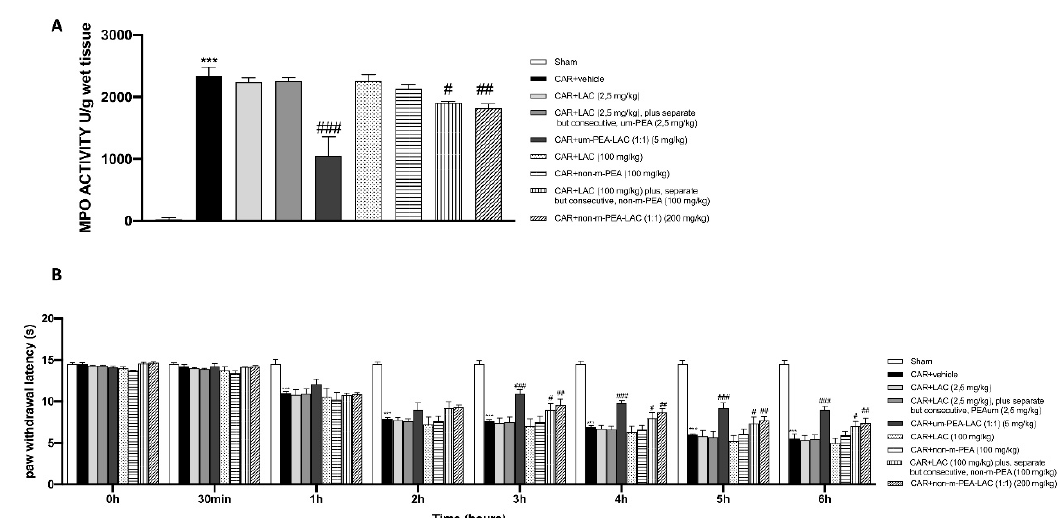
Figure 2. Efficacy of um-PEA and LAC treatment on MPO activity and CAR-induced thermal hyperalgesia. Paw tissues from CAR-treated animals displayed an increased MPO activity compared to the sham group. Um-PEA and LAC (5 mg/kg) treatment produced significant reduction in MPO activity; MPO levels were also discreetly lower in CAR + LAC (100 mg/kg) plus, separate but consecutive, non-m-PEA (100 mg/kg), and CAR + non-m-PEA-LAC groups (1:1) (200 mg/kg). All the other treatments did not show any significant reduction ( A ). Um-PEA and LAC (5 mg/kg) led to an inhibition of the CAR-induced thermal hyperalgesia at 3 h from CAR injection and, also, for subsequent time points, compared to CAR-administrated group. A moderate inhibition was detected in CAR + LAC (100 mg/kg) plus, separate but consecutive, non-m-PEA (100 mg/kg), and CAR + non-m-PEA-LAC groups (1:1) (200 mg/kg). In contrast, all other oral treatments did not attenuate the CAR-induced hyperalgesic response ( B ). Data are representative of at least three independent experiments. Values are means ± SEM. One-Way ANOVA test. *** p < 0.001 vs. sham; # p < 0.05 vs. CAR; ## p < 0.01 vs. CAR; ### p < 0.001 vs. CAR.